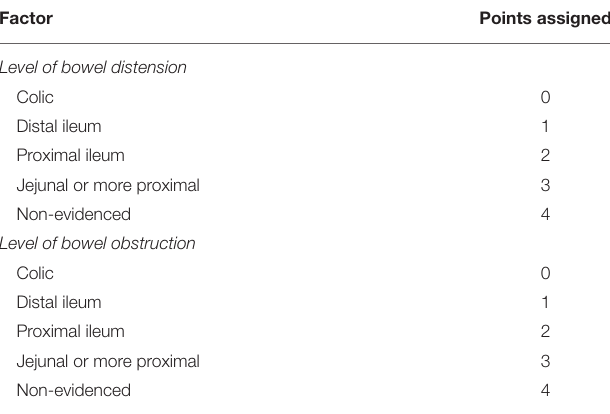
TABLE 6 | Point assigned to each condition to build the carcinosis level assessment for peritoneum (CLAP) score. Factor Points